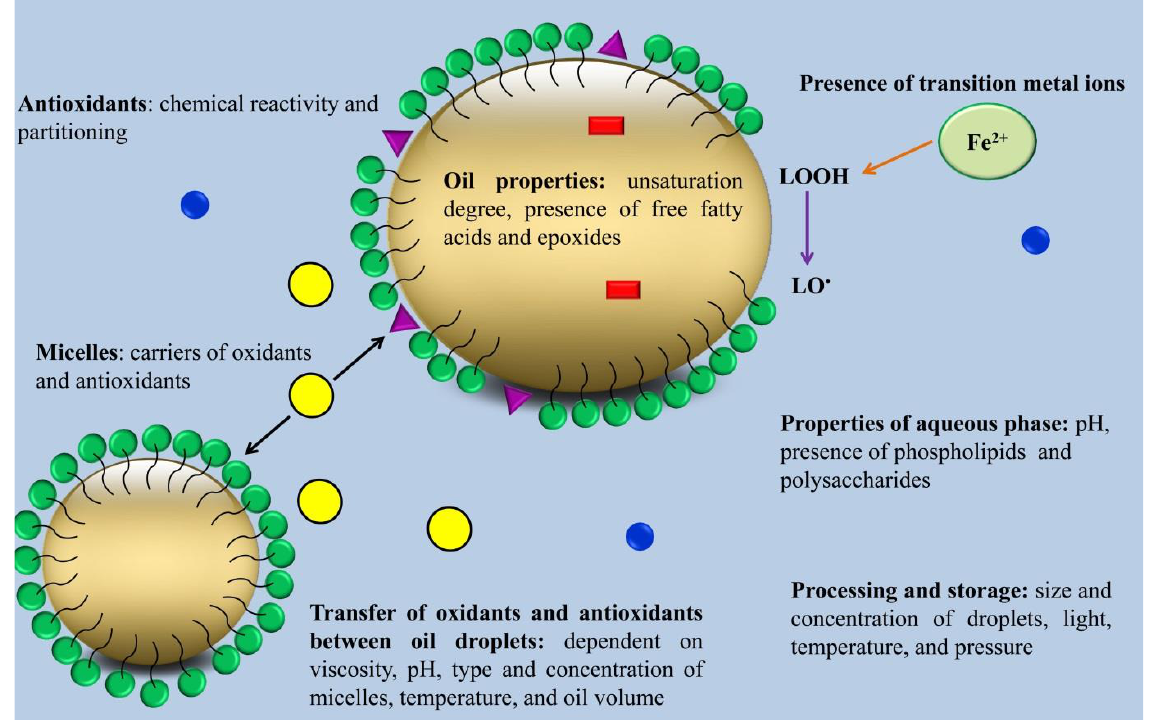
Figure 1. Factors affecting O/W emulsion oxidation (hydrophobic antioxidants: red rectangle; hydrophilic antioxidants: blue circle; amphiphilic antioxidants: purple triangle; and micelles: yellow circle ) (adopted from Ref. [27]).